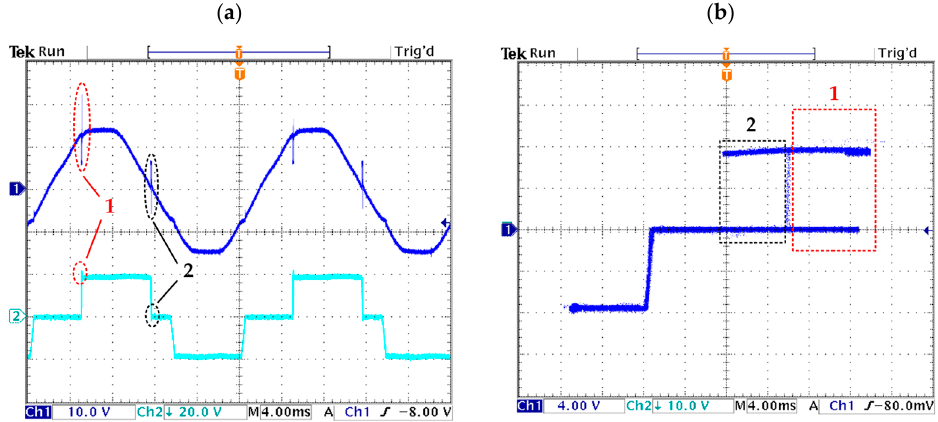
Figure 16. Phase voltage and current waveforms ( a ) and corresponding u–i characteristic ( b ) of the AC side of the semiconverter. Firing angle 𝛼 = 45° .